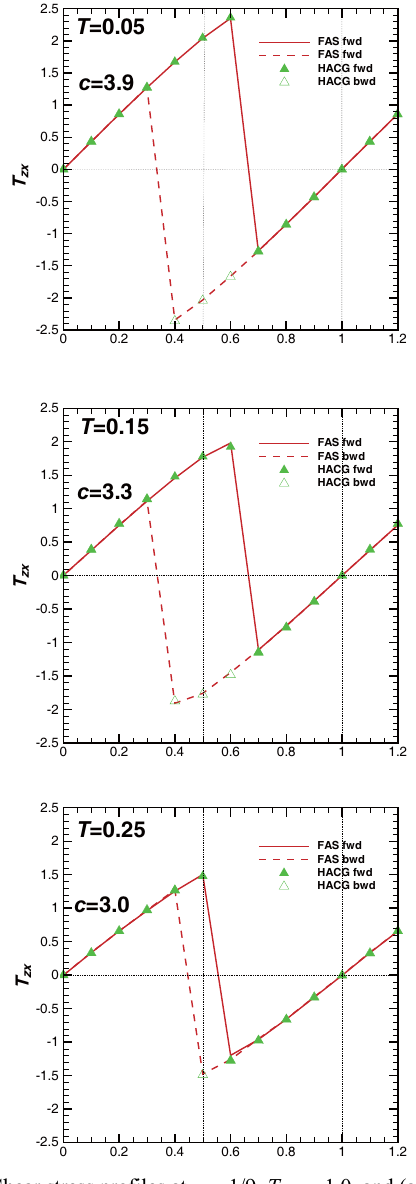
Fig. 8 Shear stress profiles at ε fs =1/9, T zz = –1.0, and (a) T = 0.05, (b) T = 0.15, and (c) T = 0.25 are generated in the fully atomistic and multi-scale simulations. The fully atomistic profile (forward, with a solid line; backward, with a dashed line) and multi-scale profile (forward, with filled triangles; backward, with hollow